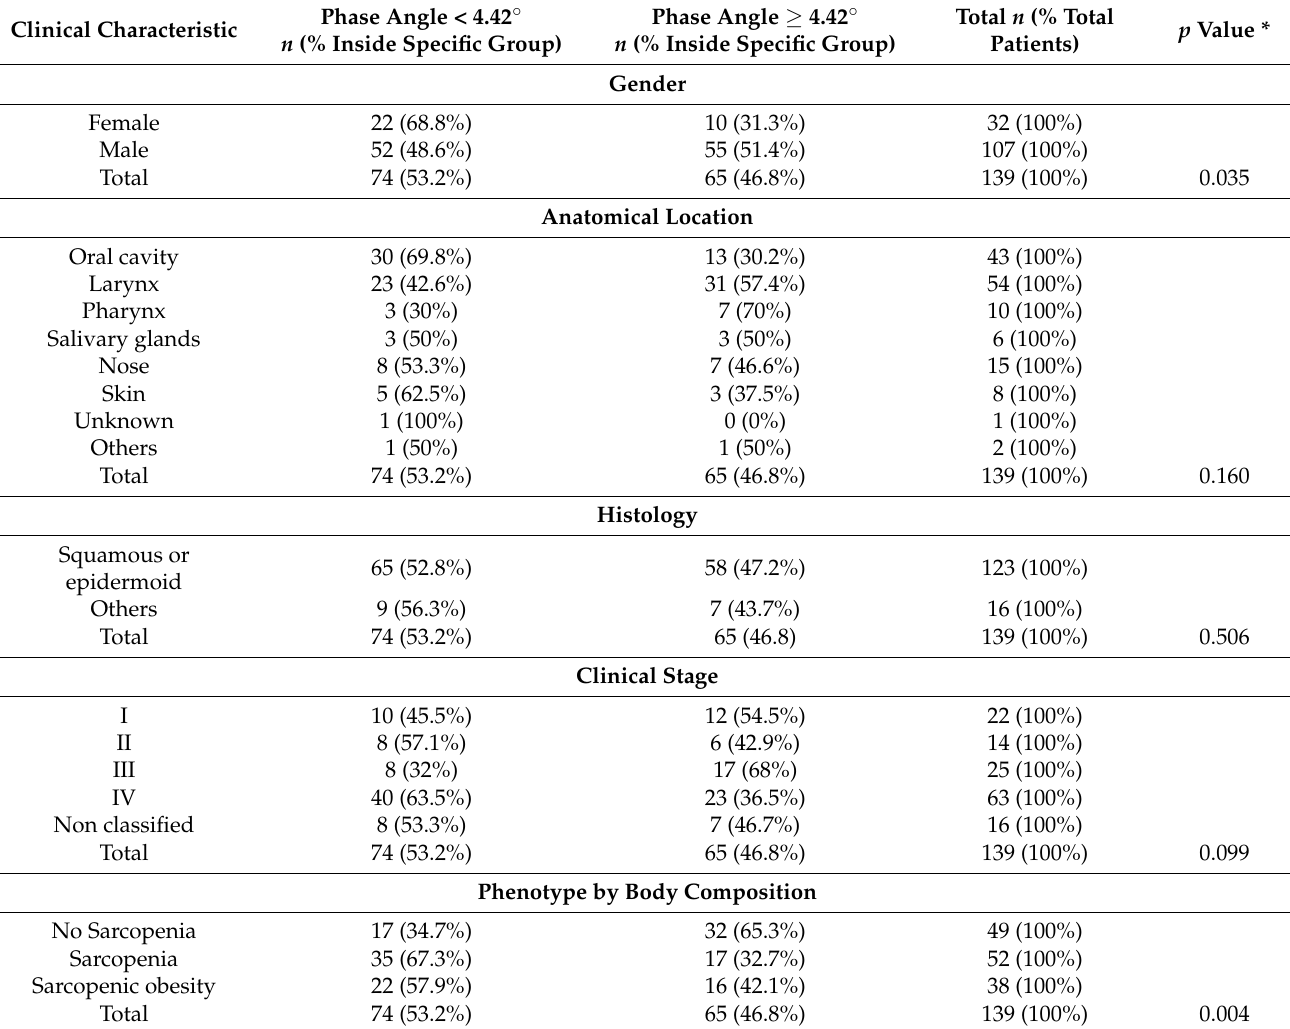
Table 1. Characteristic of the cohort of head and neck cancer patients